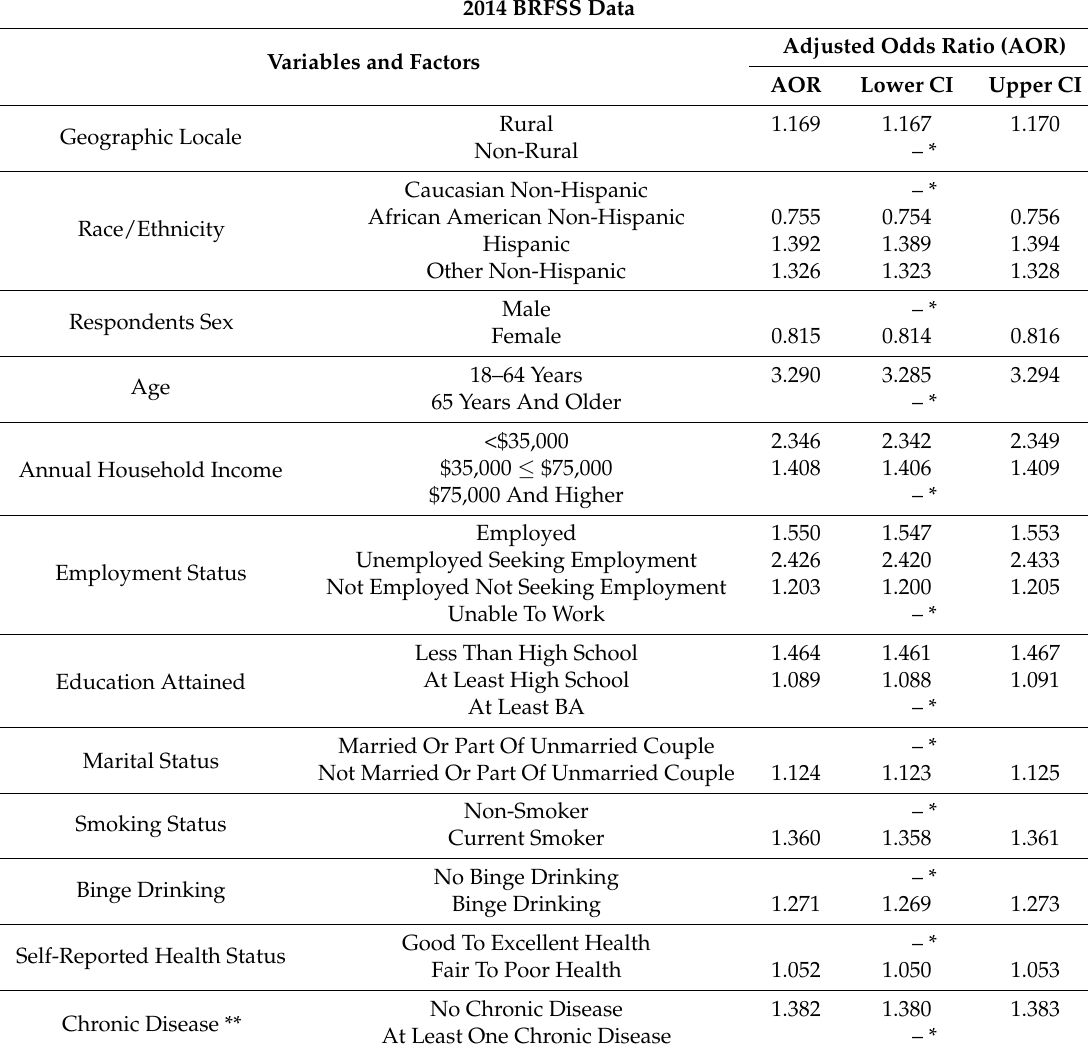
Table 3. Logistic Regression Analysis of US Veterans with Dependent Variable = Health Service Deficits